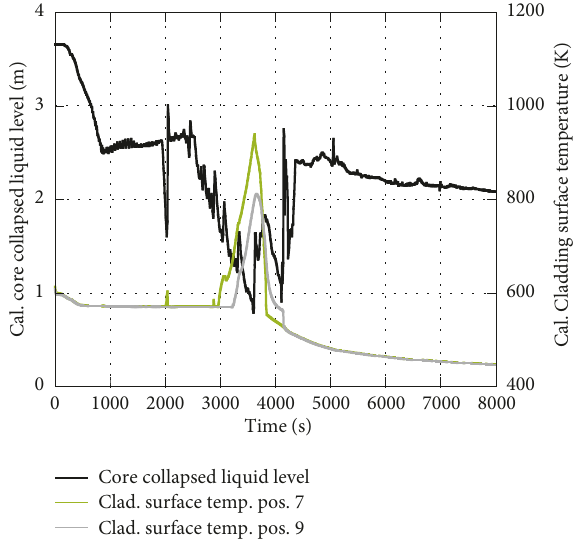
Figure 11: TR-LF-18 test results for fluid temperatures near top of SG U-tubes in loop A.